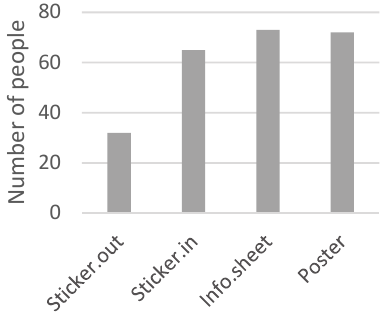
Figure A23. The number of participants that had seen the different types of information, second survey (81 individuals).